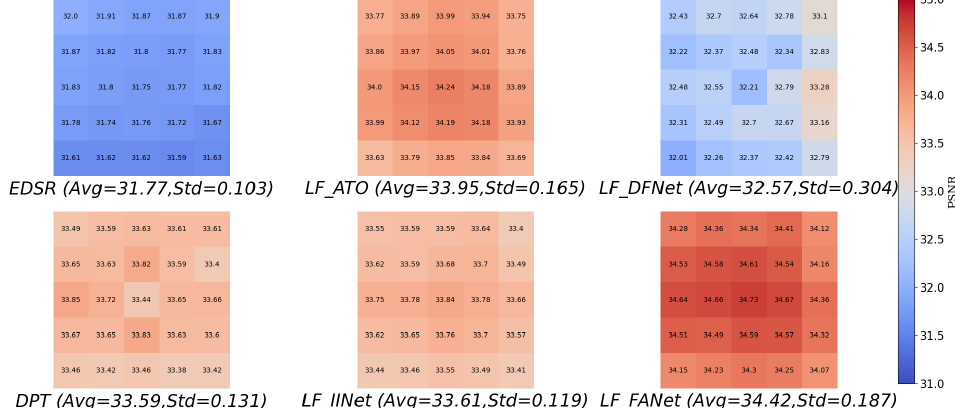
Figure 13. Visualization of PSNR distribution among different perspectives on 5 × 5 LF for 4 × SR. Here, we compare our LF-FANet to 5 state-of-the-art SR methods. Our LF-FANet achieves high reconstruction quality with a balanced distribution among different perspectives.